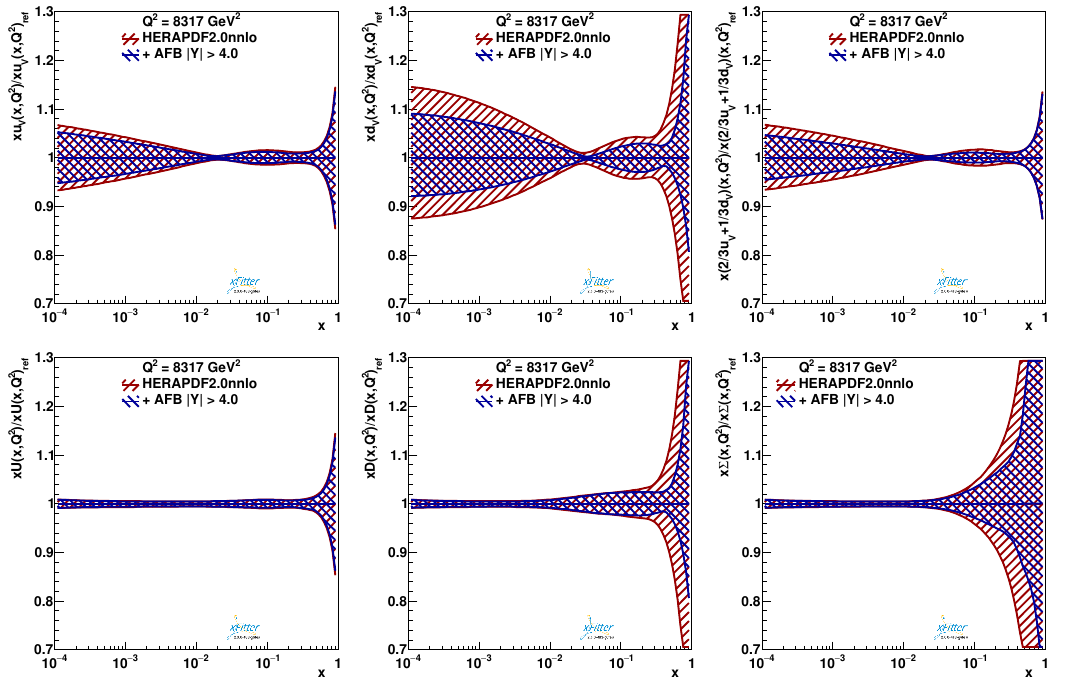
Figure 5 . Original (red) and pro(cid:12)led (blue) distributions for the normalised distribution of the ratios of (top row, left to right) u -valence, d -valence and ((2 = 3) u + (1 = 3) d )-valence and (bottom row, left to right) u -sea, d -sea quarks and ( u + d )-sea quarks of the HERAPDF2.0nnlo PDF set obtained using A (cid:3) pseudodata corresponding to an integrated luminosity of 3000 fb (cid:0) 1 , applying a FB rapidity cut of j y ‘‘ j > 4 : 0. The acceptance region of the detector has been enlarged up to j (cid:17) ‘ j < 5, and the pro(cid:12)ling is performed through the LO code.